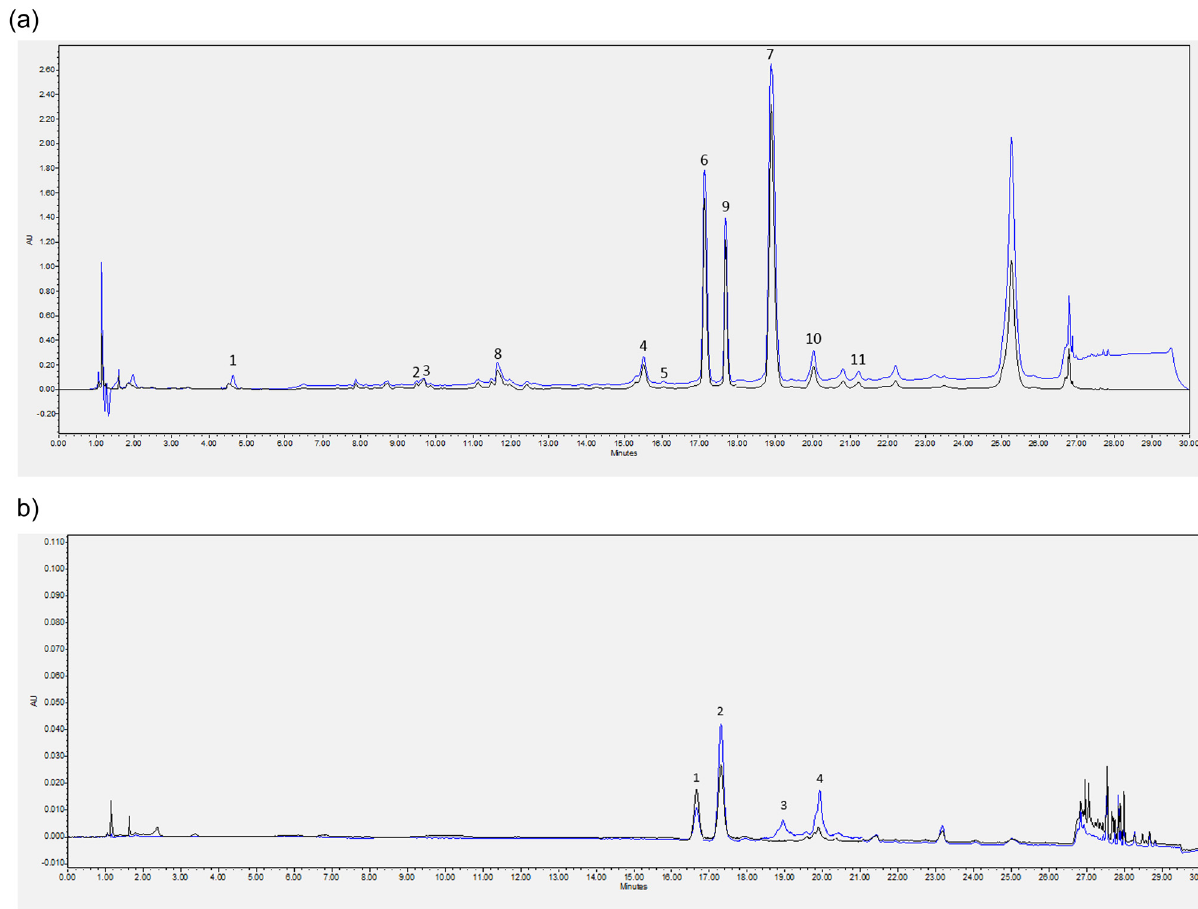
Figure 1: Comparison of chromatograms of phenolic acids for P. serotina and P. padus ( a ) , comparision of chromatograms of fl avonoids for P. serotina and P. padus ( b ) . ( a ) Comparison of chromatograms of phenolic acids for P. serotina ( black line ) and P. padus ( blue line ) leaves: 1 – gallic acid, 2 – 2,5 - dihydroxobenzoic acid, 3 – 4 - dihydroxobenzoic acid, 4 – ca ff eic acid, 5 – syringic acid, 6 – p - coumaric acid, 7 – ferulic acid, 8 – chlorogenic acid, 9 – sinapic acid, 10 – t - cinnamic acid, 11 – vanillic acid. ( b ) Comparison of chromatograms of fl avonoids for P. serotina ( black line ) and P. padus ( blue line ) leaves: 1 – quercetin, 2 – naringenin, 3 – rutin, 4 – catechin.